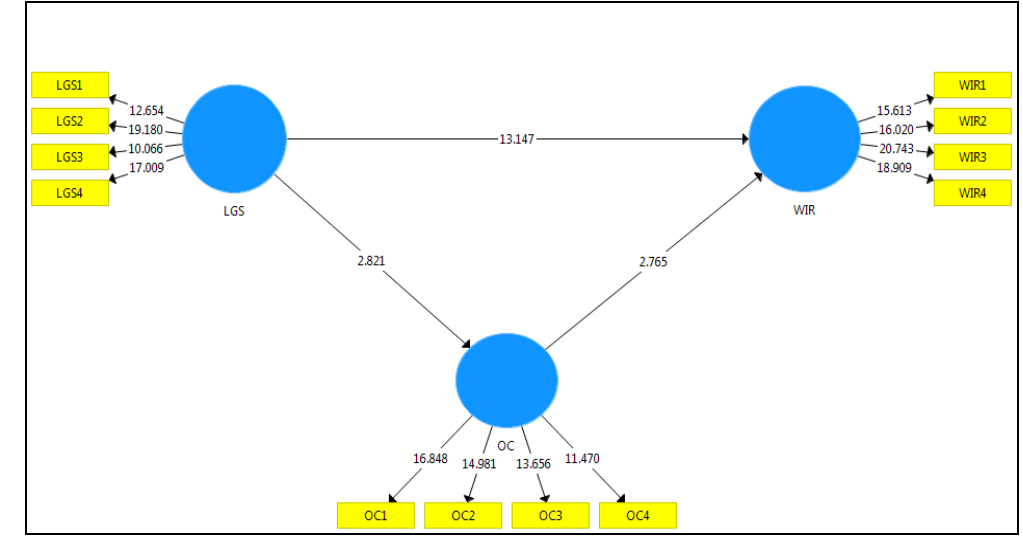
Figure.1. Total Indirect